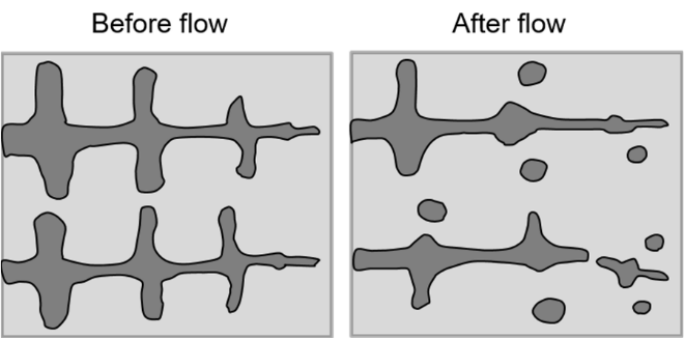
Figure 18. Schematic diagram of dendrite multiplication [108]. Reprinted under the Creative Com- mons Attribution License (CC-BY) 4.0.